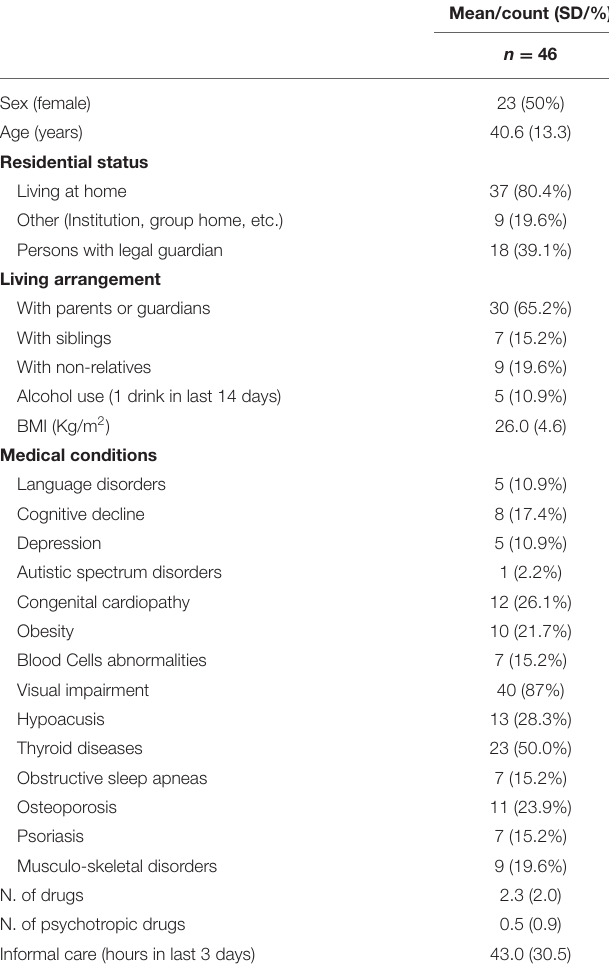
TABLE 1 | Sample characteristics before the